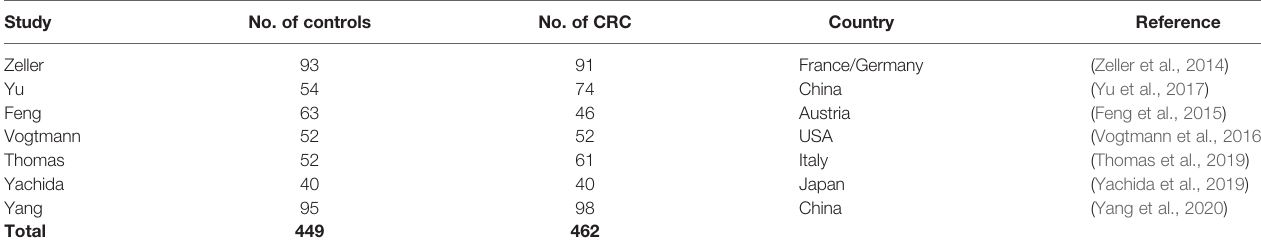
TABLE 1 | Characteristics of metagenomic datasets used in this